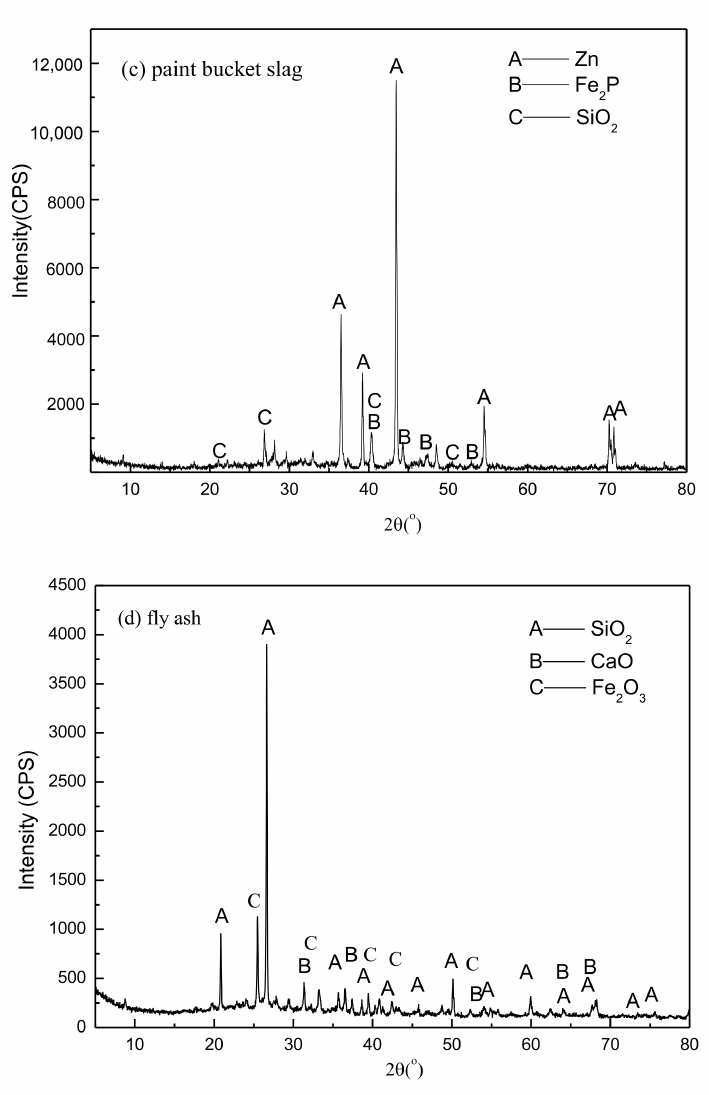
Figure 1. XRD spectra of river bottom silt ( a ) , waste oil mud ( b ), paint bucket slag ( c ), and fly ash ( d